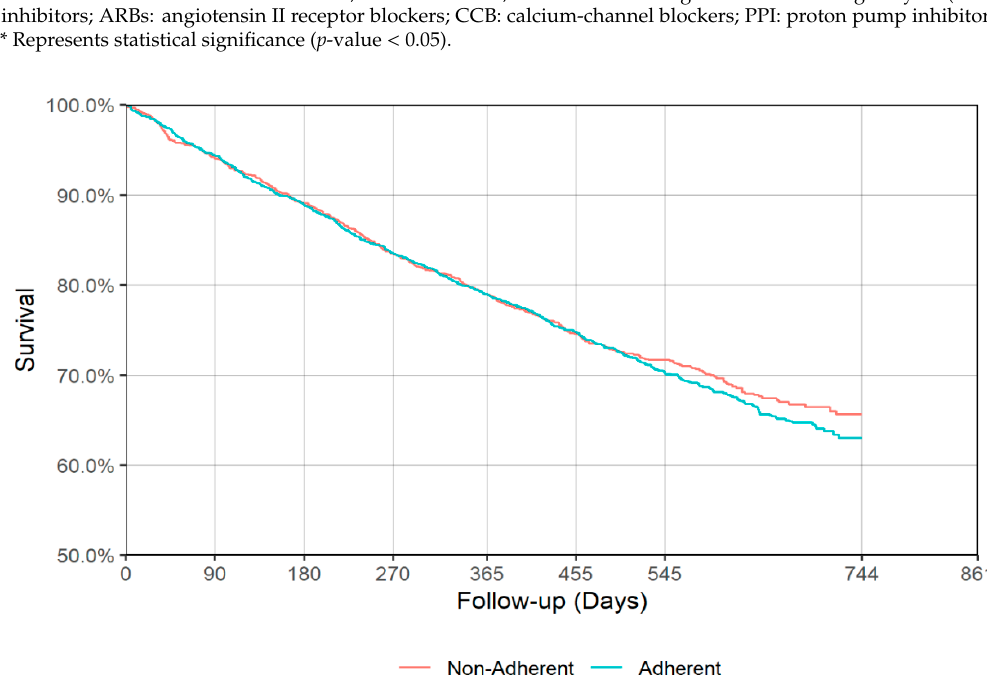
Figure 4. IPT-weighted Kaplan–Meier curve for all-cause mortality (continuation phase). Weighted log-rank p = 0.518.